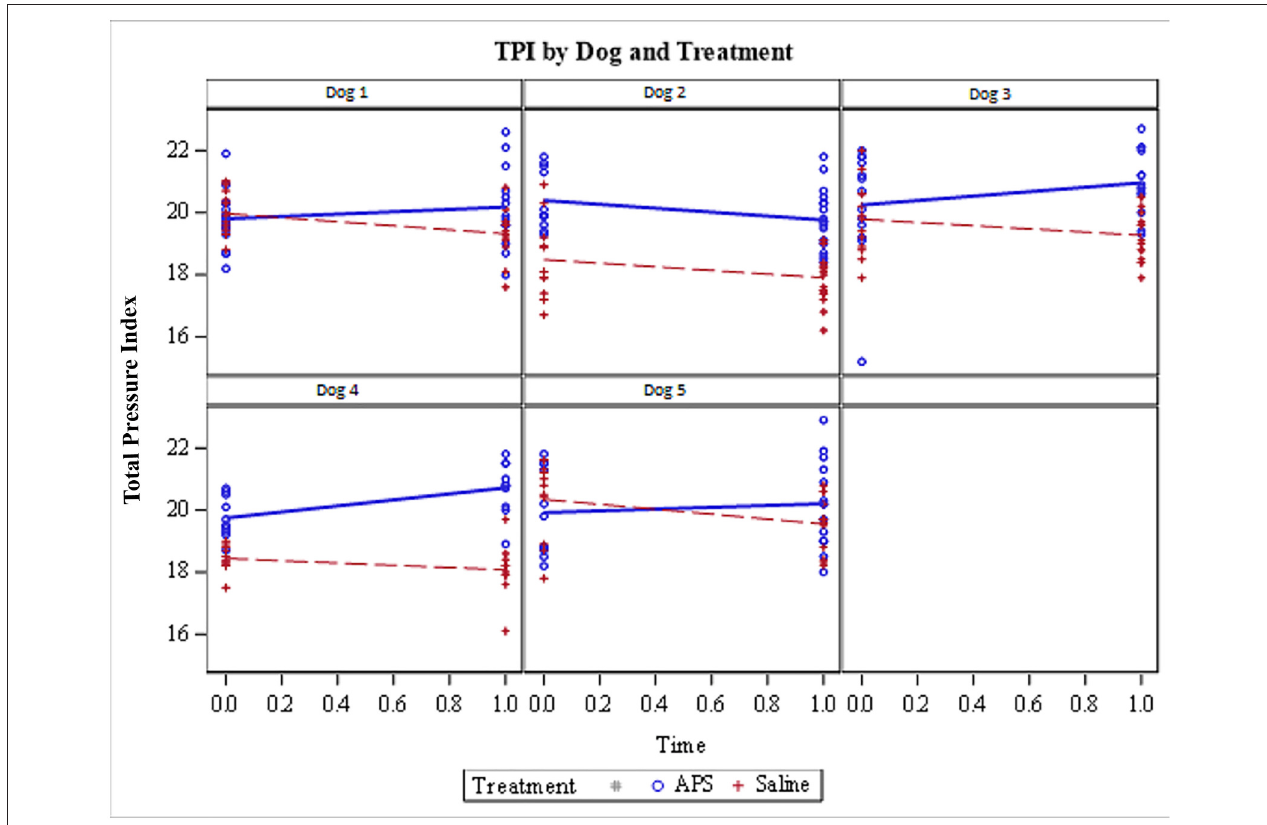
FIGURE 1 | Total Pressure Index (TPI) for each of the 5 dogs included in the pilot study. Limbs treated with APS are represented by blue data points (and lines) and the limbs treated with saline are shown by red data points (and lines). TPI was measured at two time points (day 0 immediately prior to treatment and day 28 following treatment). Four out of 5 dogs showed improvement in TPI in the APS-treated limb; the one exception was Dog 2. All 5 dogs showed a decrease in the relative pressure distribution to the saline-treated